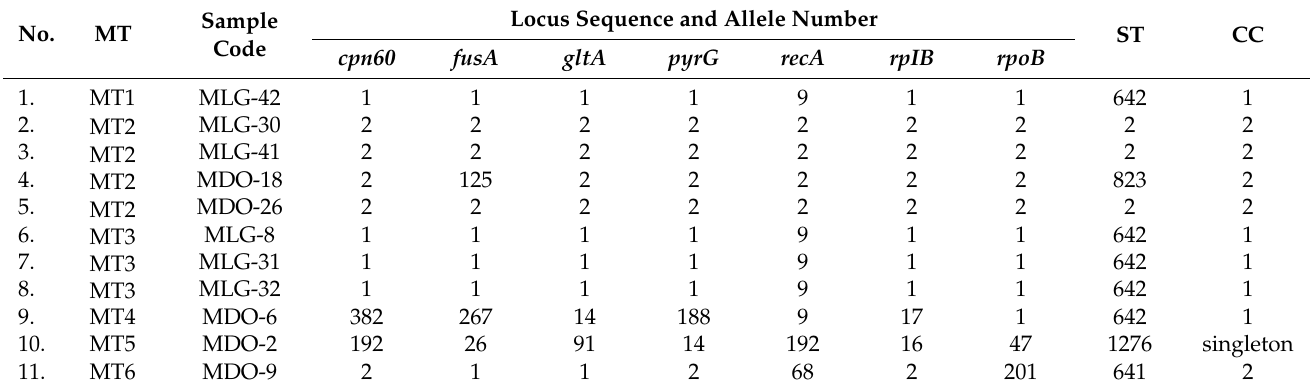
Table 5. MLST and CC analyses of eleven CRAB-cc in Dr. Saiful Anwar Hospital, Malang, and Prof. Dr. R. D. Kandou Hospital, Manado compared to the MLVA